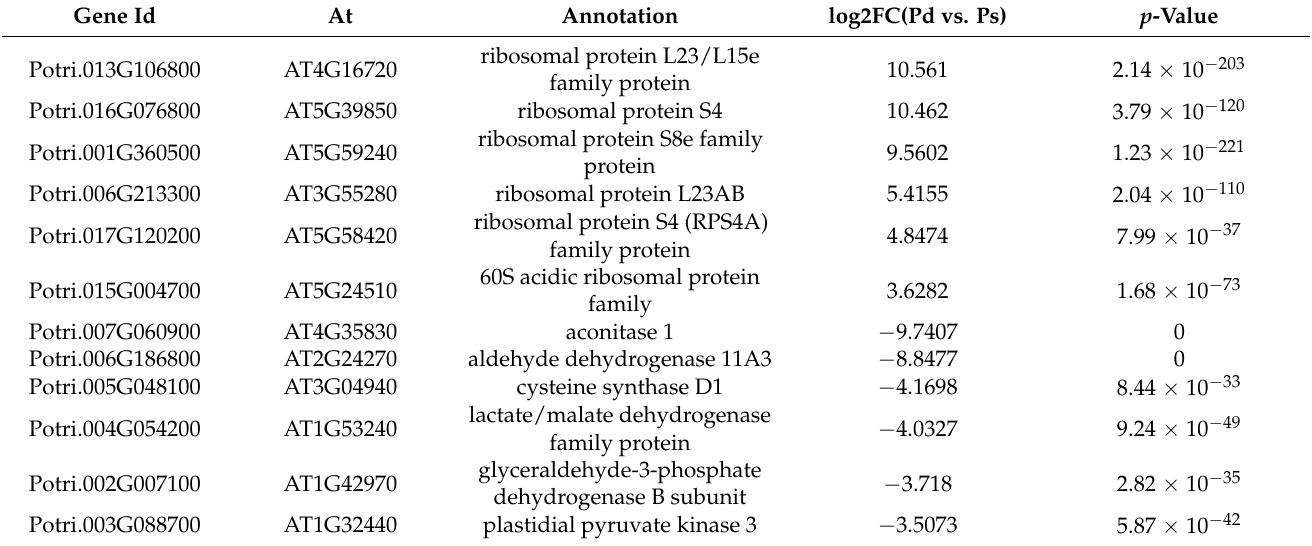
Figure 3. KEGG pathway enrichment analysis of two genotypes. ( A ) Pd vs. Ps up-regulation DEGs enriched KEGG pathway scatterplot. ( B ) Pd vs. Ps down-regulation DEGs enriched KEGG pathway scatterplot. Rich factor refers to the ratio of the number of DEGs located in the KEGG to all genes in the KEGG pathway. Table 2. Summary of DEGs in leaf